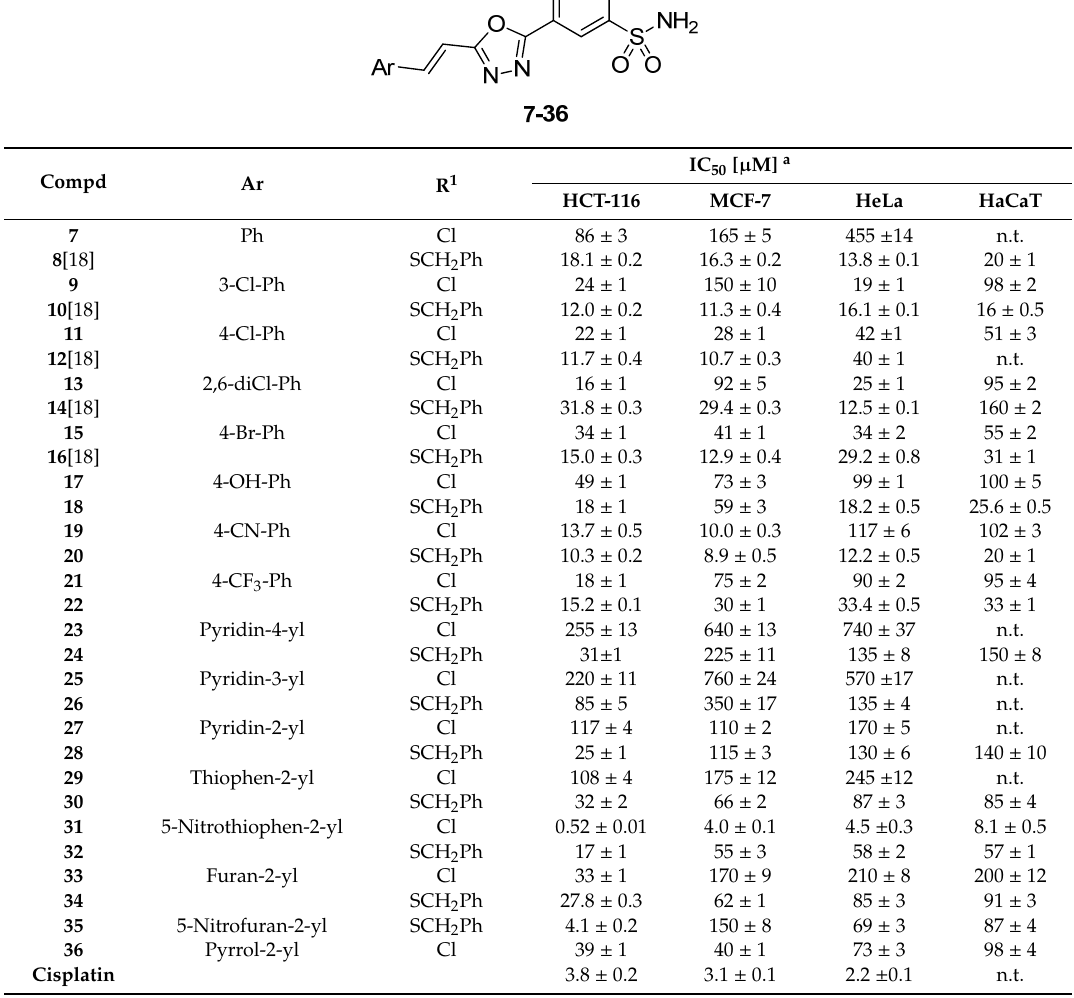
Table 1. Cytotoxicity of compounds 7 – 36 towards human cancer cell